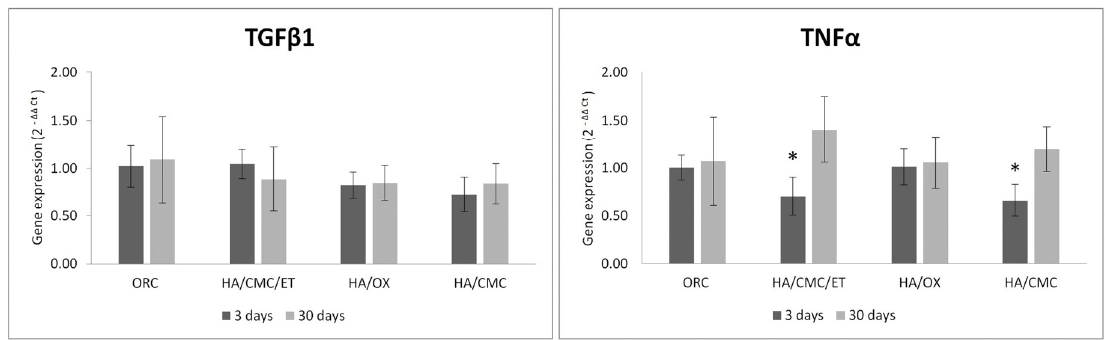
Figure 3. Results of gene expression analysis. Gene expression was compared to untreated controls. Graphs represent the means ± S.D. n = 4–5. * p < 0.05 in comparison to the control.